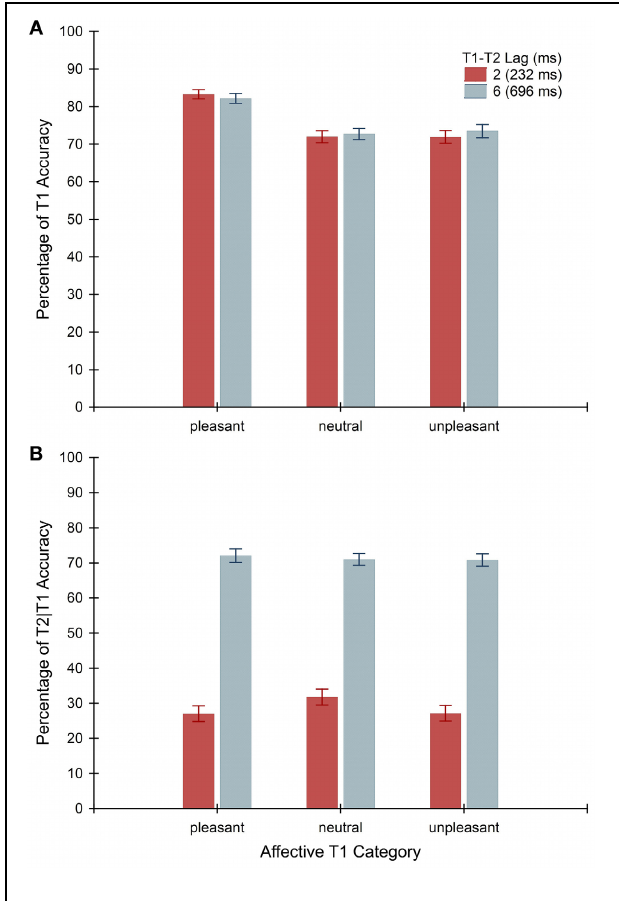
FIGURE 3 | Mean behavioral accuracy ( n = 83 students) in the attentional blink task as a function of affective T1 category at the 232-ms (red bars) and 696-ms (blue bars) interval between the first and second targets (T1-T2 lag). Error bars indicate standard errors of means. Plot (A) illustrates the percentage of correctly identified T1 items. Plot (B) displays the percentage of accurate T2 report given T1 identification.